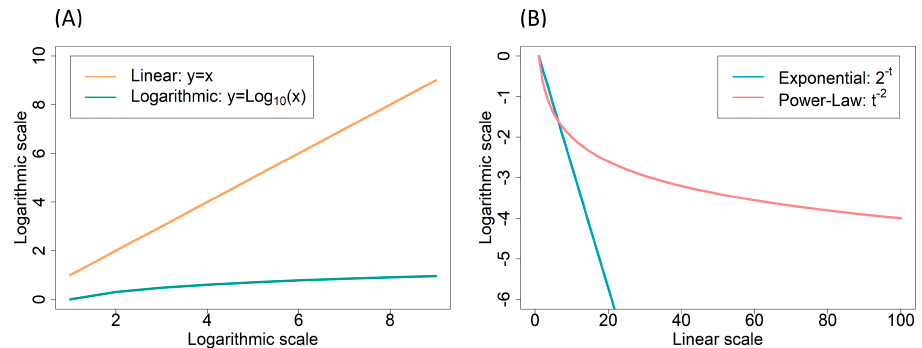
Figure 2. ( A ): Linear and logarithmic functions. Suppose that x increases from 1 to 10 9 , close to the world population size. Then, y increases from 1 to 10 9 in the case of the 𝑦 = 𝑥 linear function, whereas the 𝑦 = 𝐿𝑜𝑔 (cid:2869)(cid:2868) (𝑥) function increases from zero to nine only. Note that both axes are at the logarithmic scale (base 10). ( B ): Exponential and power-law decay. The exponential function 2 − t decreases much faster than the power-law function t − 2 . Note that the vertical axis is at the logarithmic scale (base 10) but not the horizontal axis.